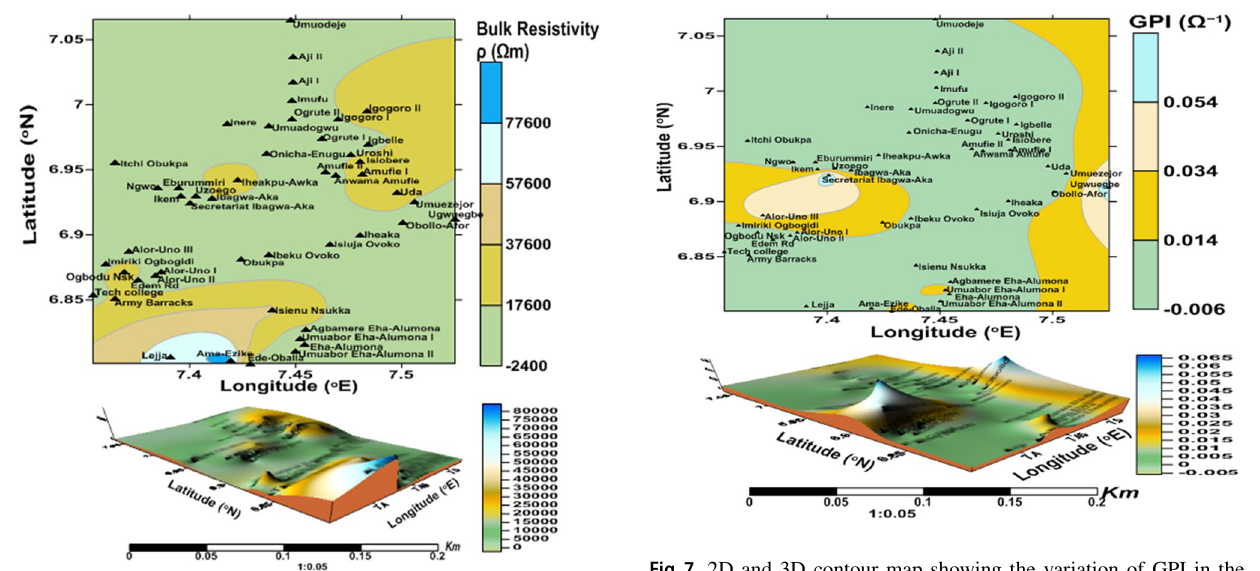
Fig. 7 2D and 3D contour map showing the variation of GPI in the study area